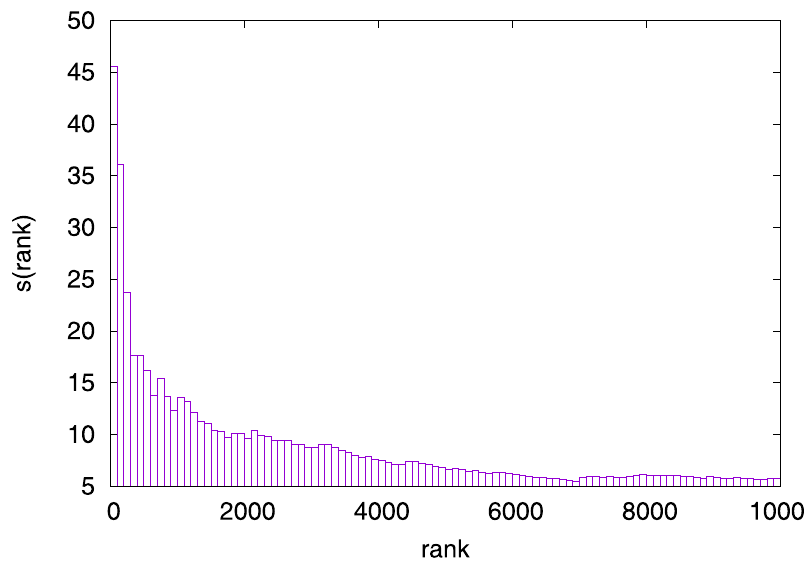
Fig 4. The ratio between the relative number of peptides W 4 and not W 4 for Trypanosoma cruzi up to position “rank” is shown.